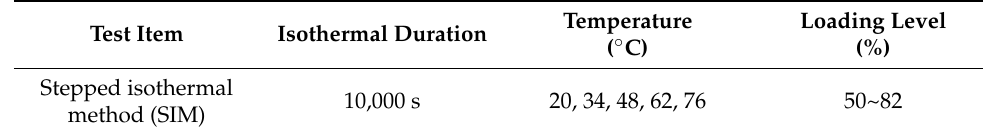
Table 2. Test design for creep deformation.